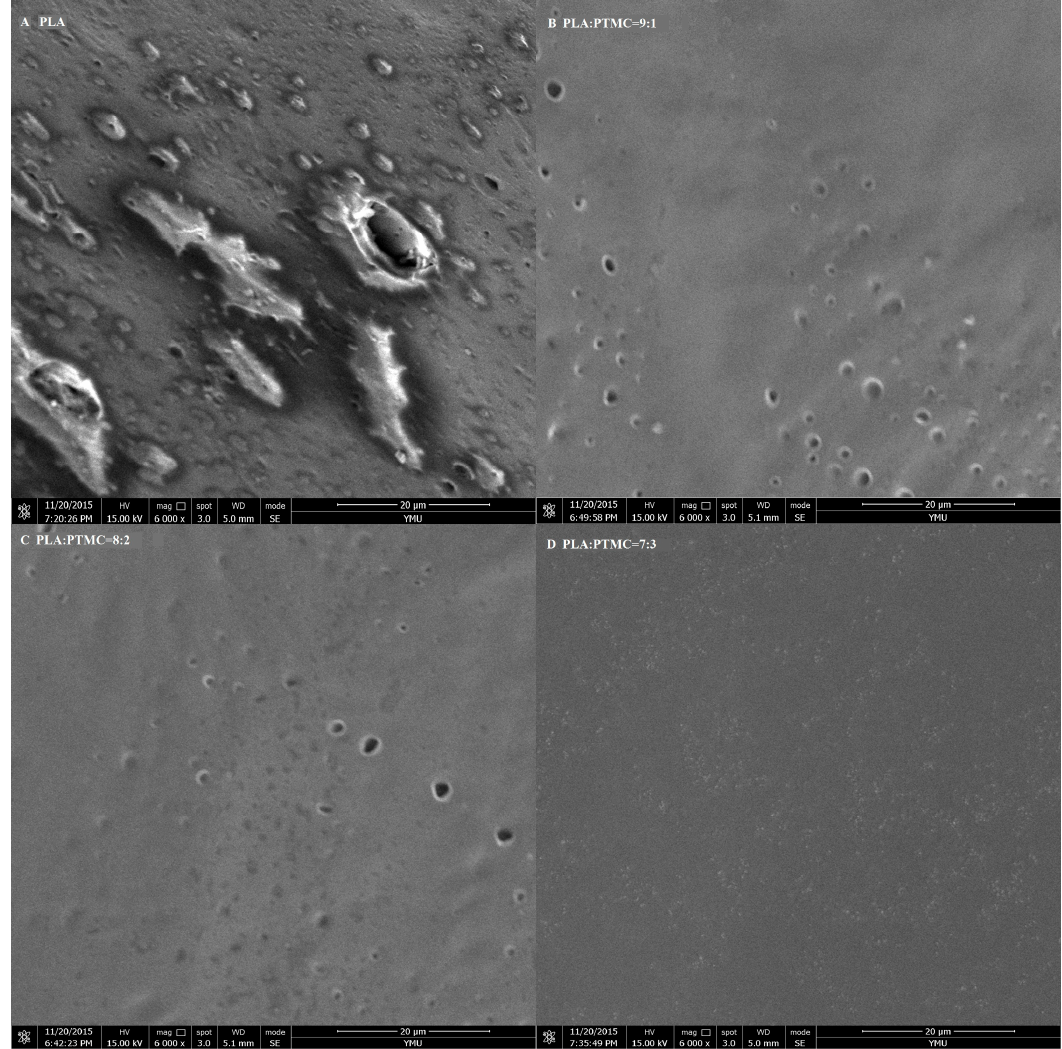
Figure 2. SEM micrographs of medical adhesive with different ratios of PLA-PTMC. ( A ) PLA; ( B ) PLA:PTMC = 9:1; ( C ) PLA:PTMC = 8:2; ( D ) PLA:PTMC = 7:3. Scale bar: 20 µm.